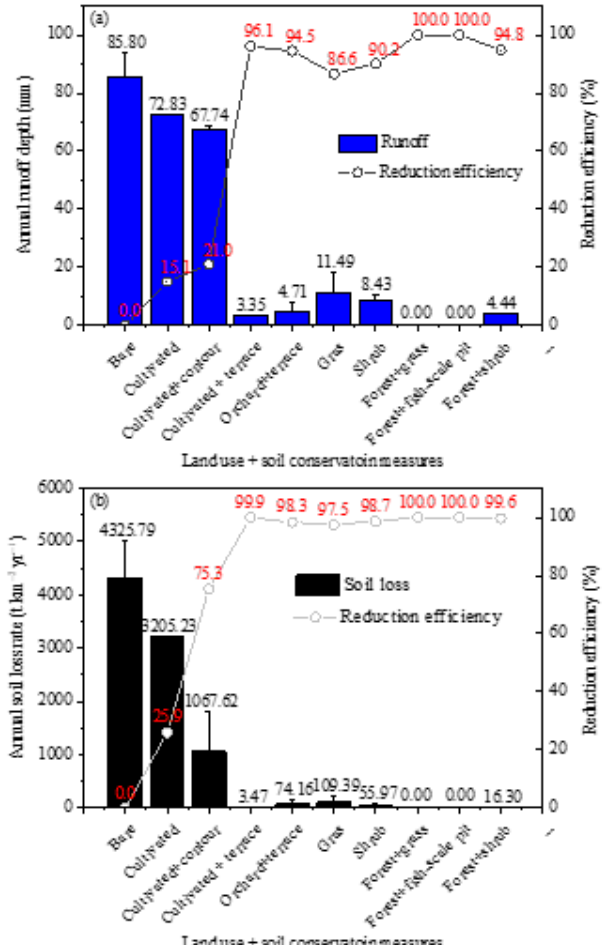
Figure 8. Annual runoff depth ( a ) and soil loss rate ( b ) under different land use and soi conservation measures for the study plots in 2014–2020. Note: On the x-axis, bare represents plots 3, 4, 21, and 22, cultivated represents plot 1, cultivated + contour represents plots 6, 18, and 20, and cultivated + terrace represents plot 17. Orchard represents plot 2 and 7, shrub represents plots 5, 9, 11, 13, 14, and 19, forest + grass represents plot 8, forest + fish-scale pit represents plot 10, forest + shrub represents plot 12, and grass represents plots 15 and 16 in Table 1.